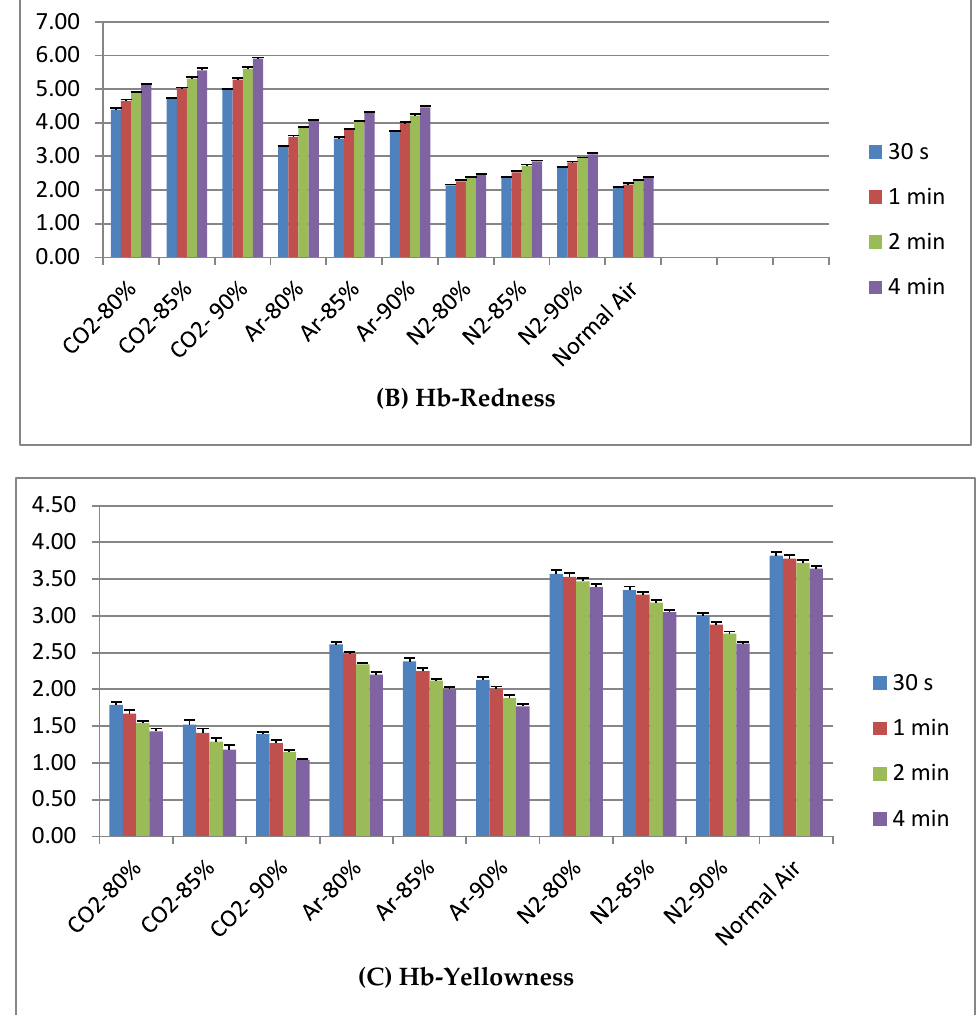
Figure 1. Effect of high concentration levels of different gas exposing conditions on Hemoglobin solution at different duration of time.